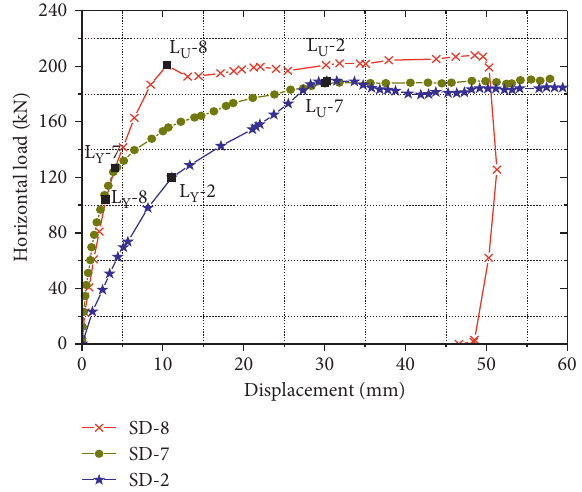
Figure 22: Load-displacement curve of specimens SD-2, SD-7, and SD-8.